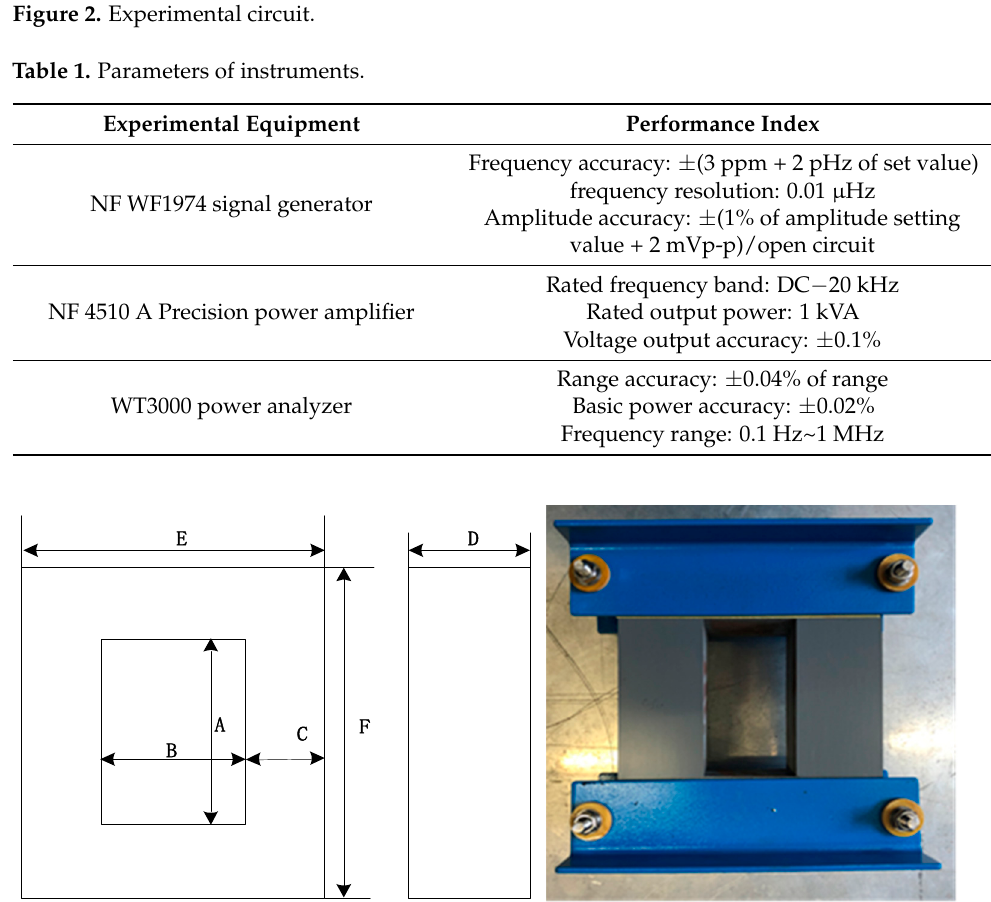
Figure 3. Dimensions of transformer core model.